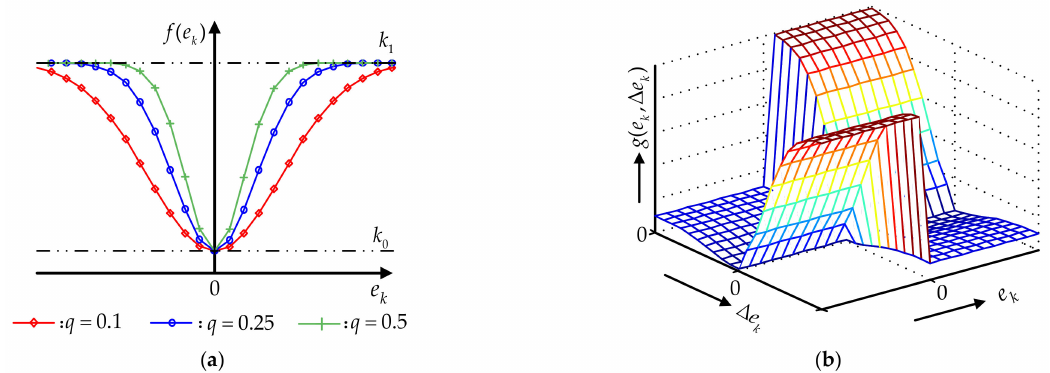
Figure 3. ( a ) Diagram of relationship of ( q , e k ) and f ( ∗ ) ; ( b ) Diagram of relationship of ( e k , ∆ e k ) and g ( ∗ )